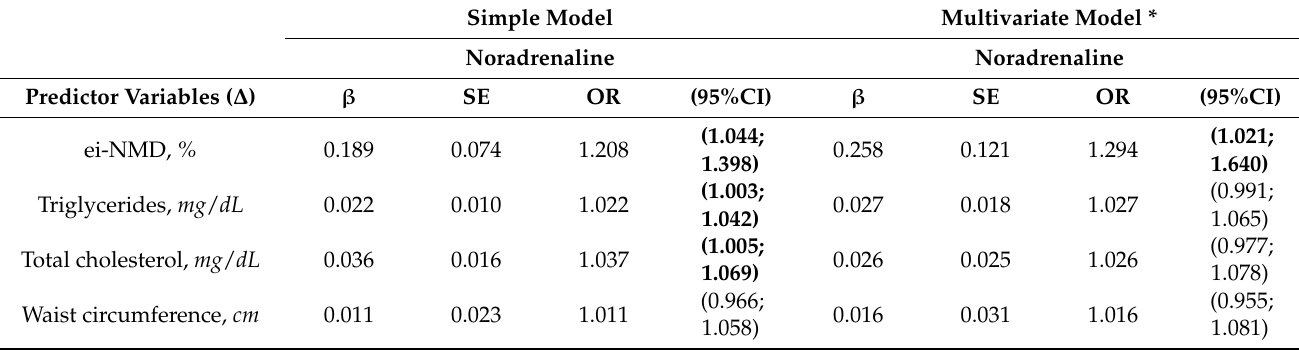
Table 3. Associations of variable changes after resveratrol and energy restriction treatments ( ∆ ) with plasma noradrenaline. Simple